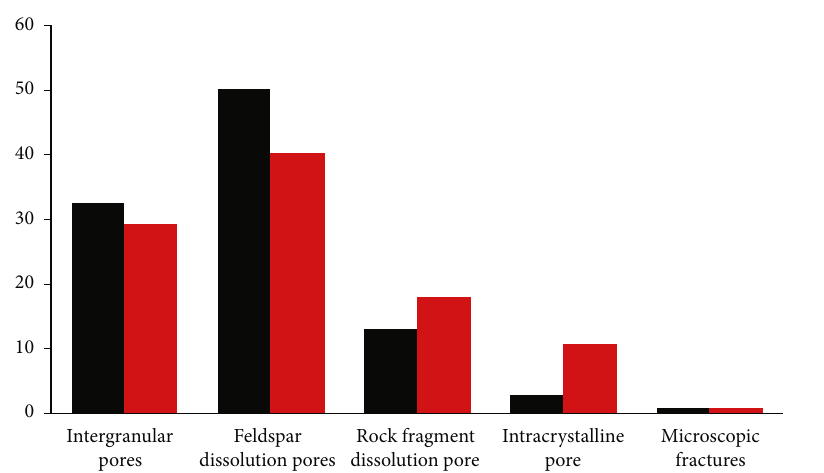
Figure 7: Fractions of di ff erent pore types in the research